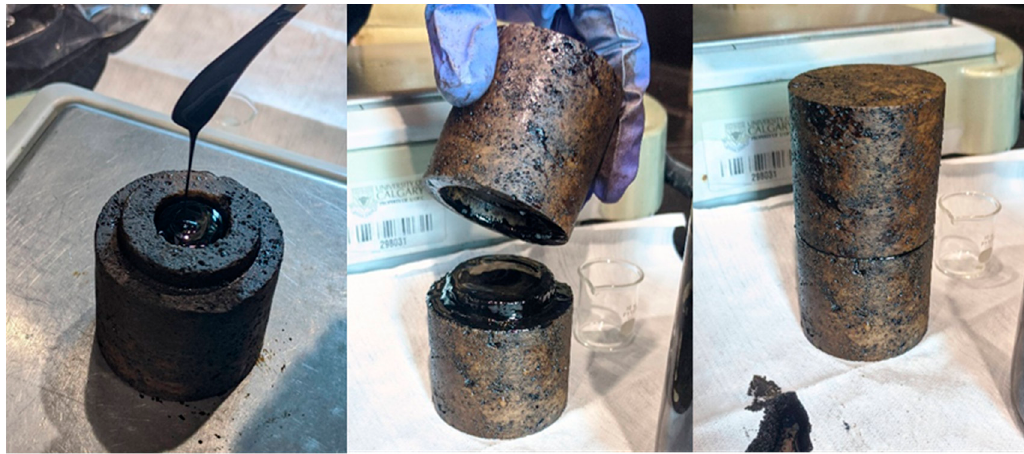
Figure 2. Photographs of an oil-saturated core plug being filled with oil and capped.